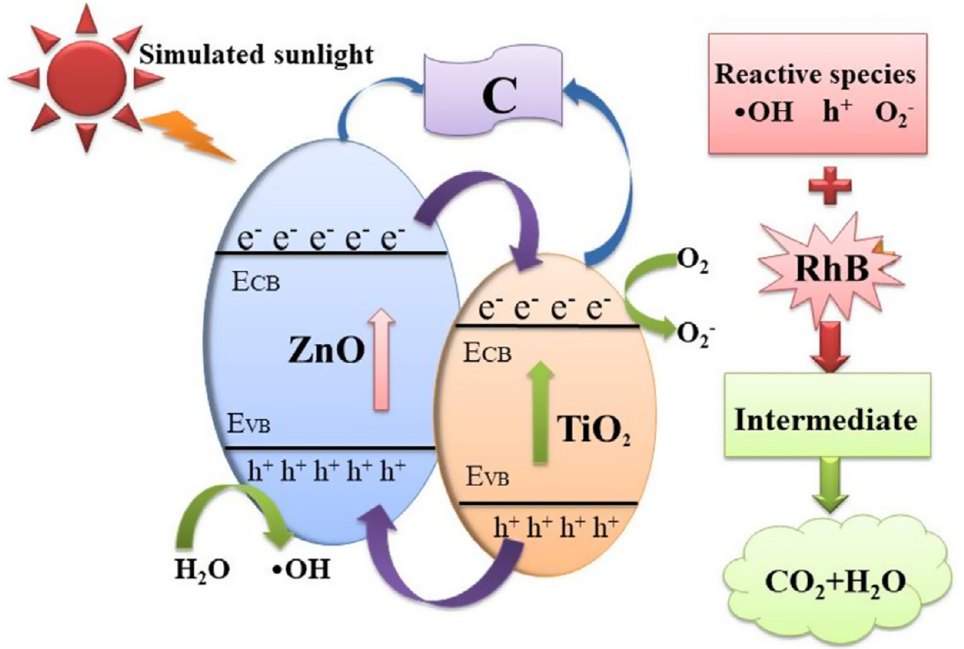
Figure 9. Schematic diagram showing the photocatalytic degradation mechanism associated with Zn/Ti-2%-MOF-600. Reprinted/adapted with permission from Ref. [223]. 2021, Elsevier. Zn/Ti-2%-MOF-600. Reprinted/adapted with permission from Ref. [223]. 2021,